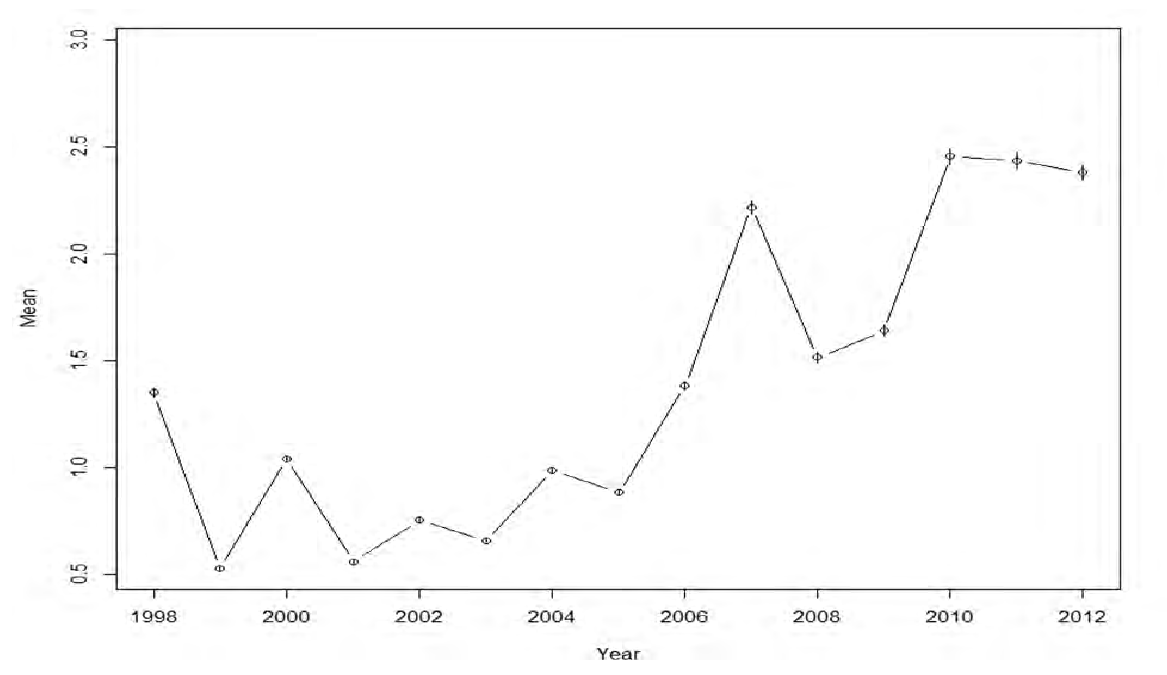
Figure 49. Abundance index for all horseshoe crabs combined in New Jersey’s Surf Clam Dredge Survey (June, July, August).